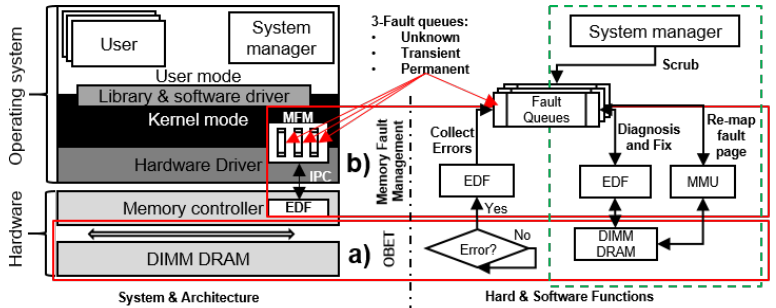
Figure 2. Summary of OBET’s contribution and a full system overview, from the devices to the operating system: ( a ) the position and operation of OBET and ( b ) the position and operation of memory fault